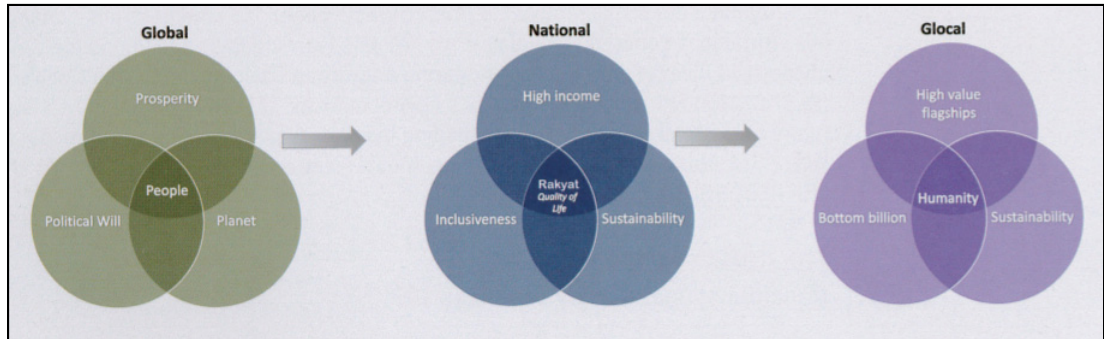
Figure 2. APEX Transformation Goals and the New Economic Model. Source: ([29], p. xiv).